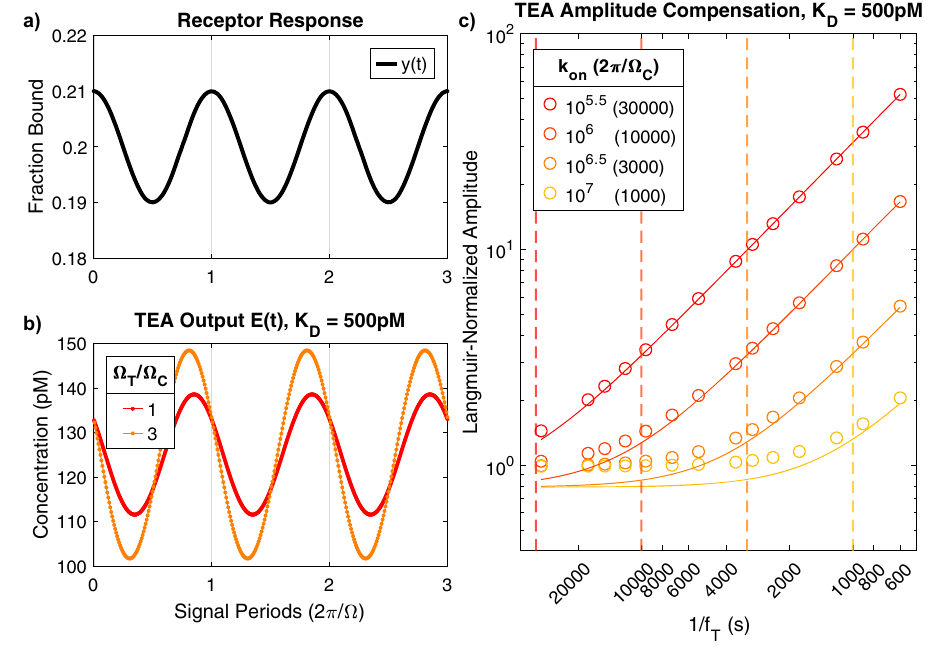
Fig.6|SimulationsofTEA.a Receptor-bindingsignal y ( t )forasimulationwith C 0 = 0.2 and C 1 = 0.01. b The signal was sampled and processed with the TEA (Eq. 7), wherethe receptor ’ skineticparameterswere K D =500pMand k on =10 6 s − 1 M − 1 .We performed this process with a fast-changing (high Ω T / Ω C ; orange) and slow- changing (low Ω T / Ω C ; red) signal to demonstrate that the TEA applies more